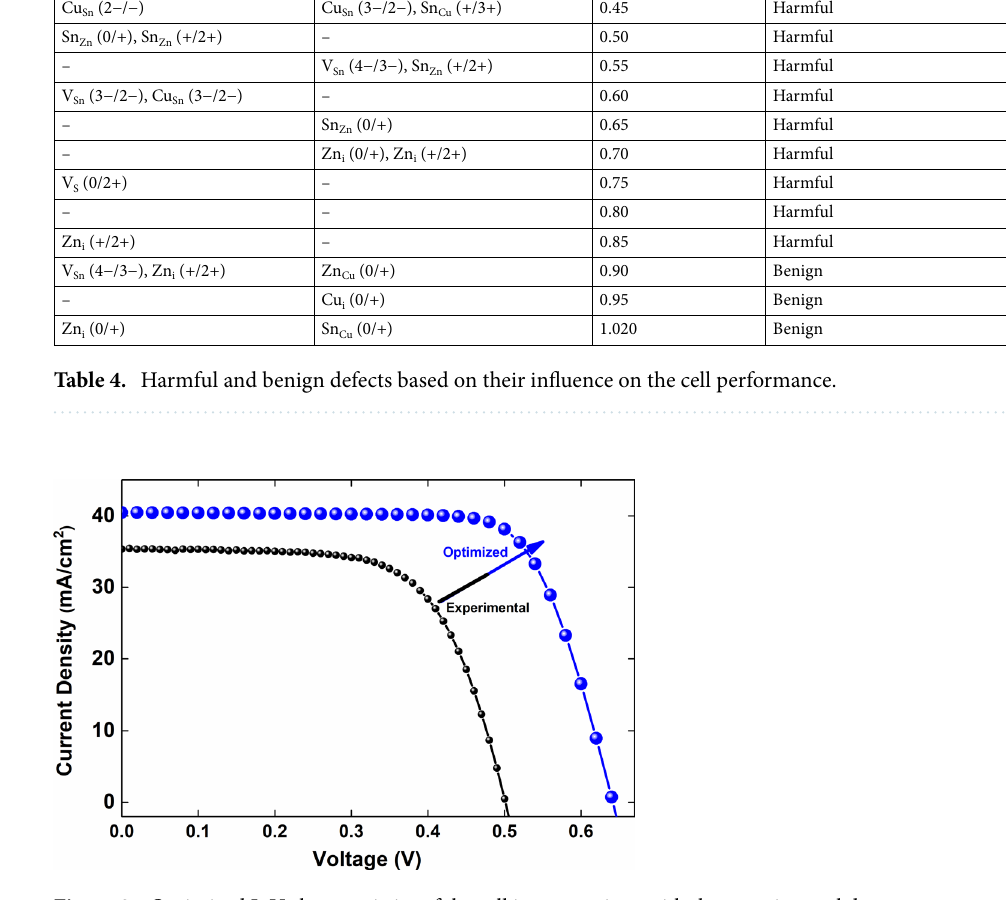
Figure 8. Optimized J–V characteristics of the cell in comparison with the experimental